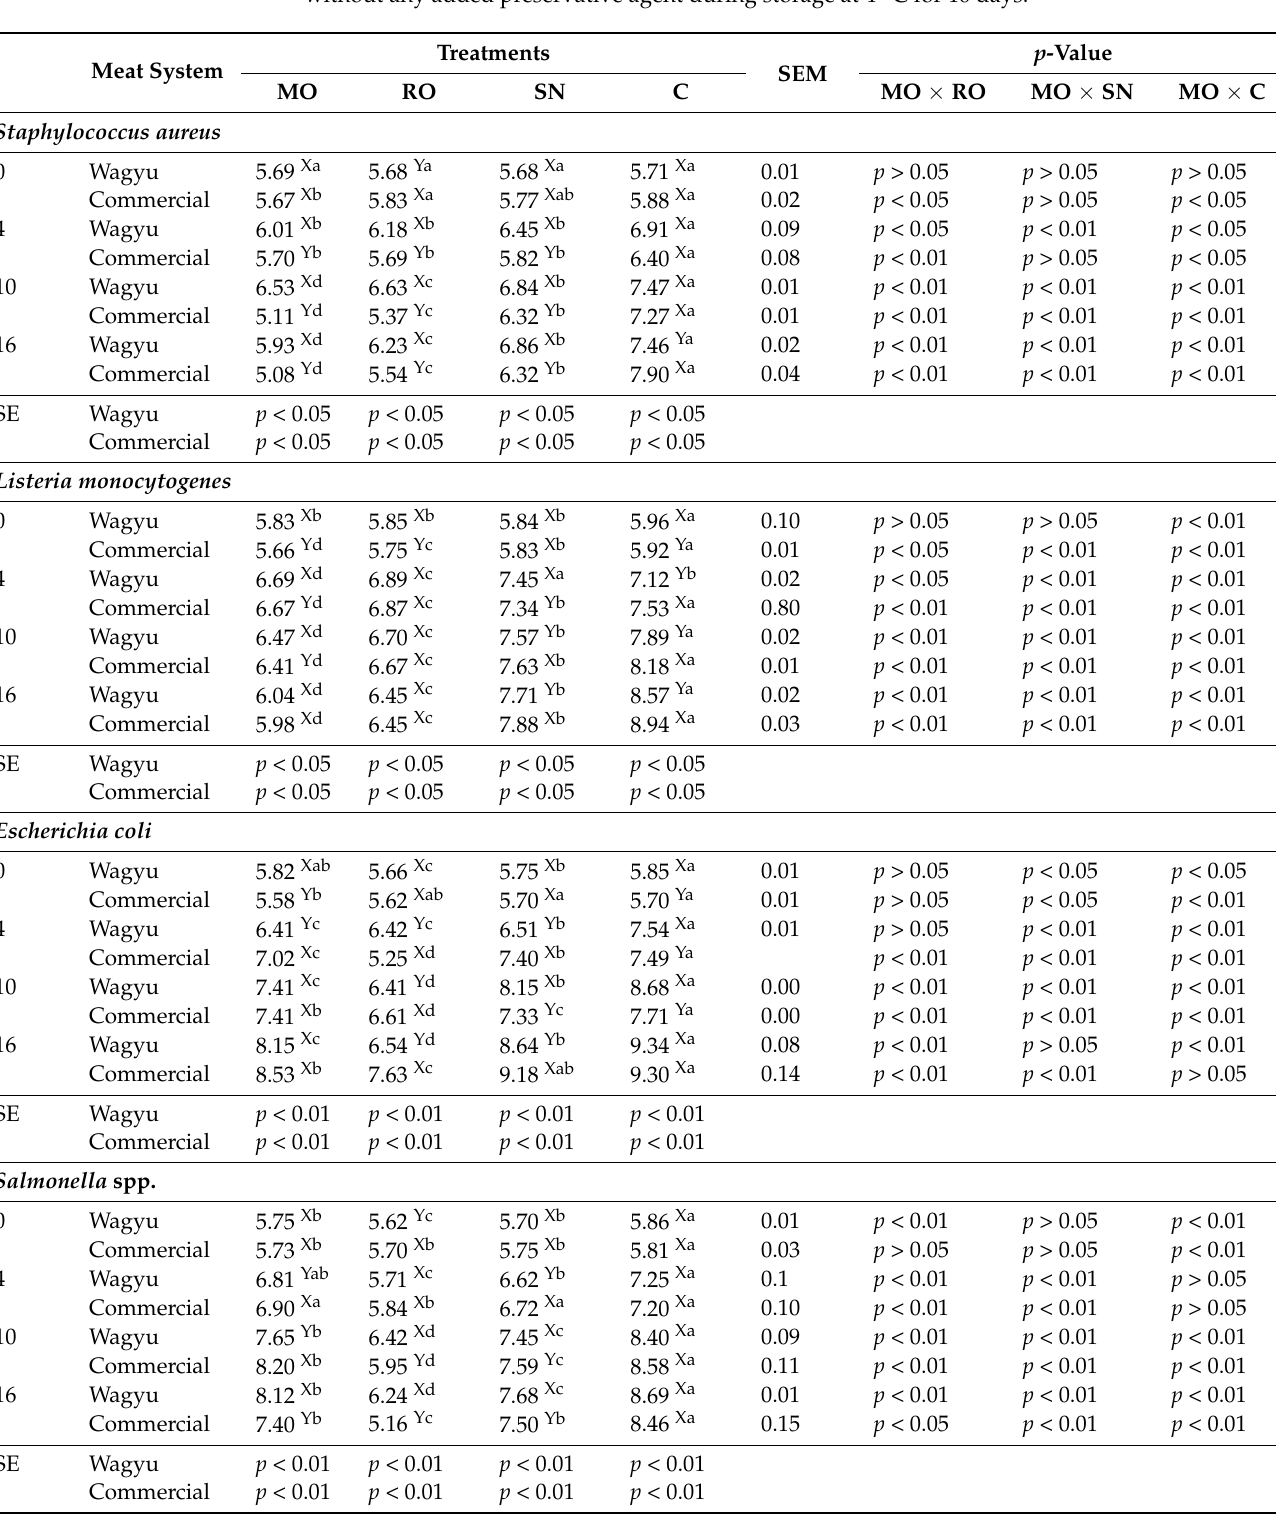
Table 2. The changes in microbial growth in wagyu and commercial breed meat matrices with or without any added preservative agent during storage at 4 ◦ C for 16